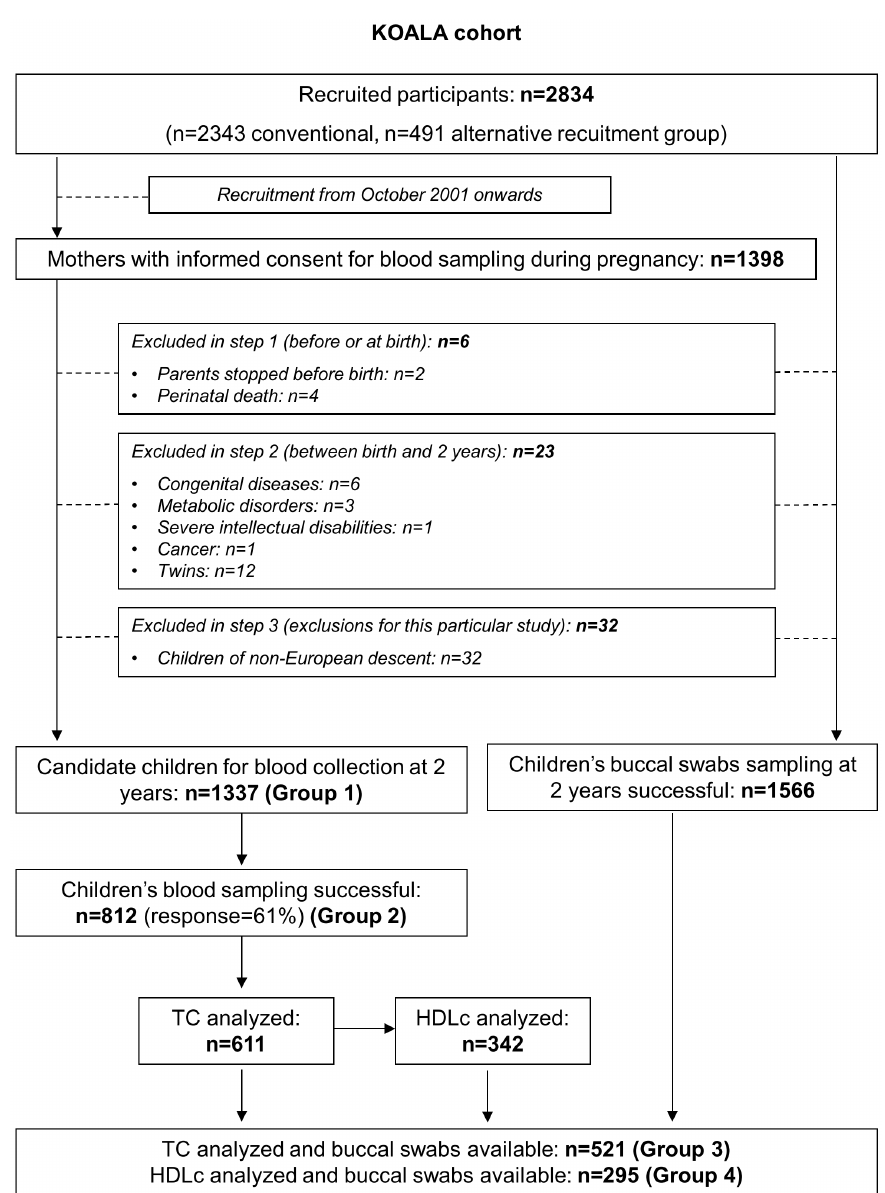
Figure 1. Flow diagram of the study design and participant selection.